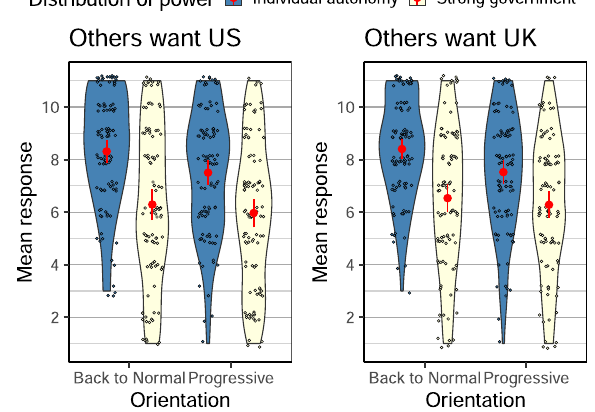
Fig. 9 Experiment 2: People ’ s perceived preferences of others for the scenarios as a function of the experimental variables. The left panel shows responses for the US sample and the right panel shows responses for the UK sample (top right). The red plotting symbols and error bars represent means and 95% con fi dence intervals. Data are jittered to avoid